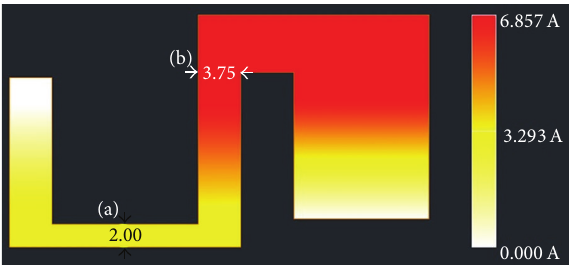
Figure 12: Current distribution across the C2 copper shape. The dimensions are in mm.